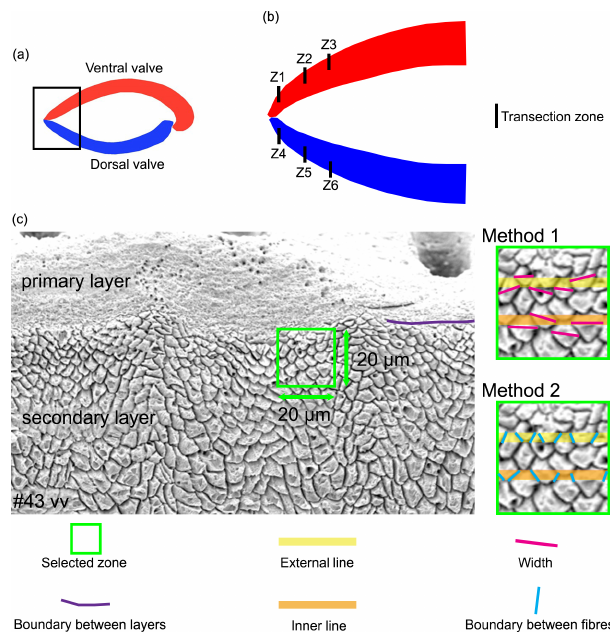
Figure 5. Methods of measurements used in the anterior transverse sections. All SEM images are oriented in the same direction: base of the primary layer facing upwards. A square (20µm × 20µm) was analysed with its upper side just overlapping the boundary between the primary and secondary layers. Method 1 refers to the measure- ment of the width of the fibres crossed by two standard lines, which were located in the same position and at the same distance in all 194 squares (yellow and orange lines); Method 2 involved the cal- culation of the numbers of boundaries between the fibres that are crossed by two standard lines. vv: ventral